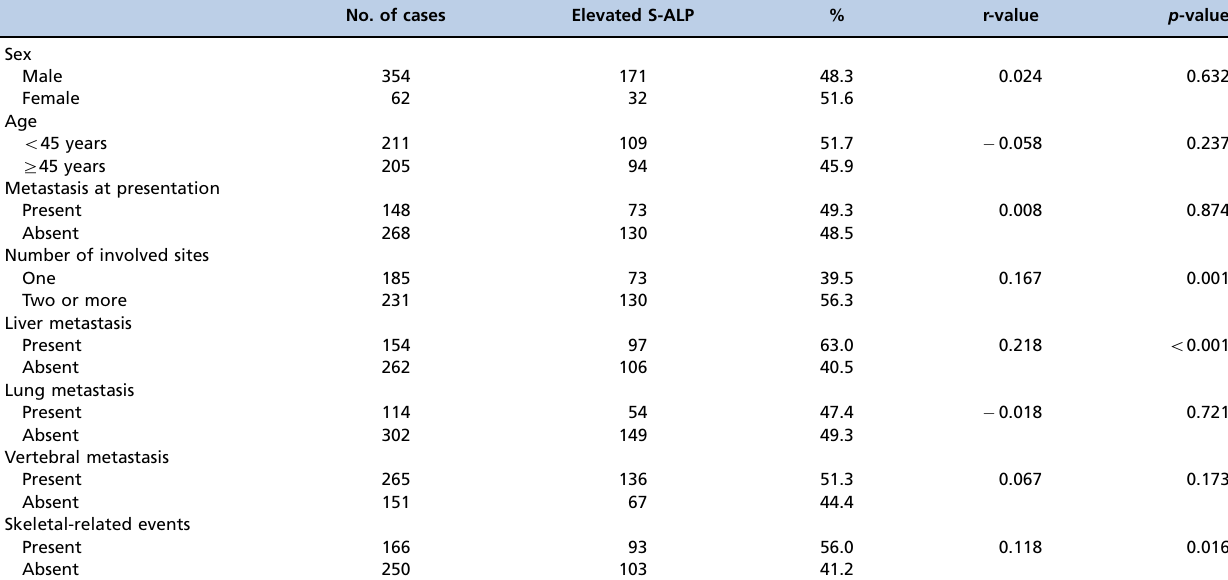
Table 1 - Increased S-ALP according to several variables in the 416